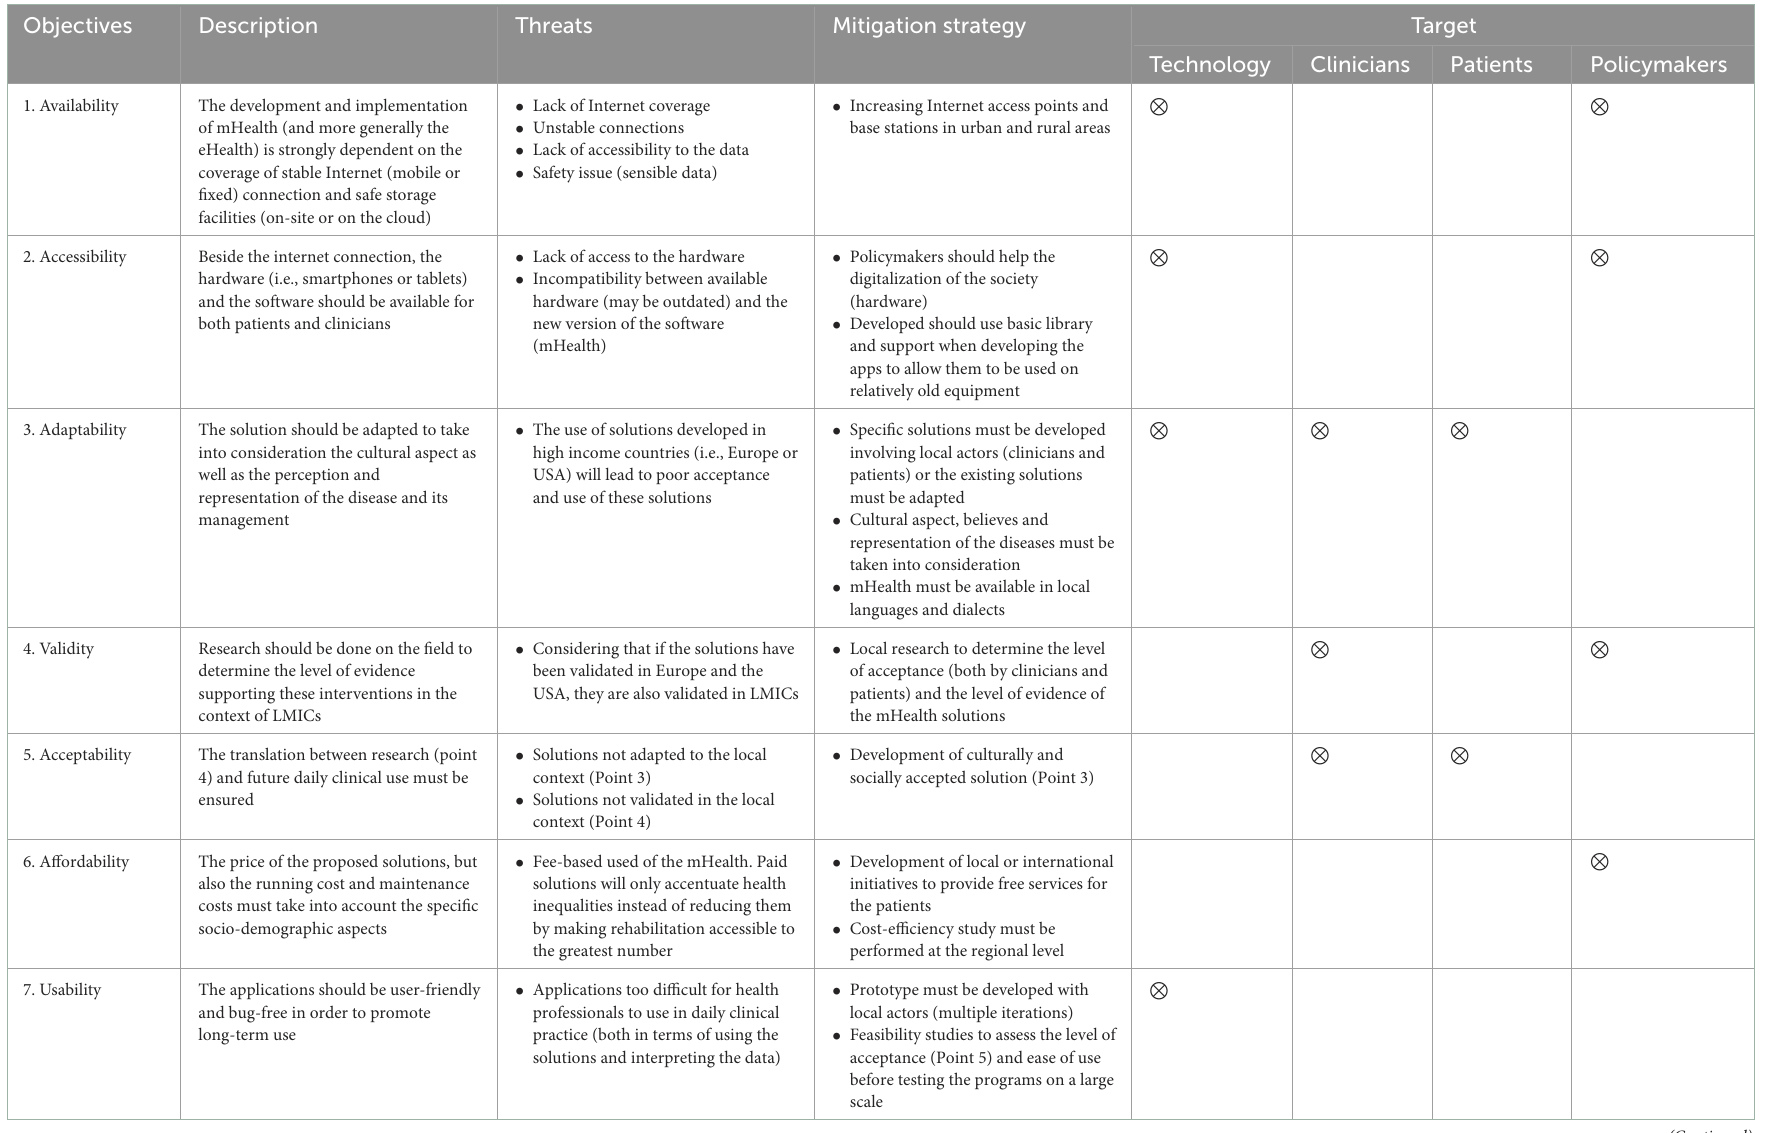
TABLE 1 Action plan to increase the use, validation, and implementation of mHealth solutions in LMICs: 10 key points with their potential threats and mitigation measures to overcome these limitations.